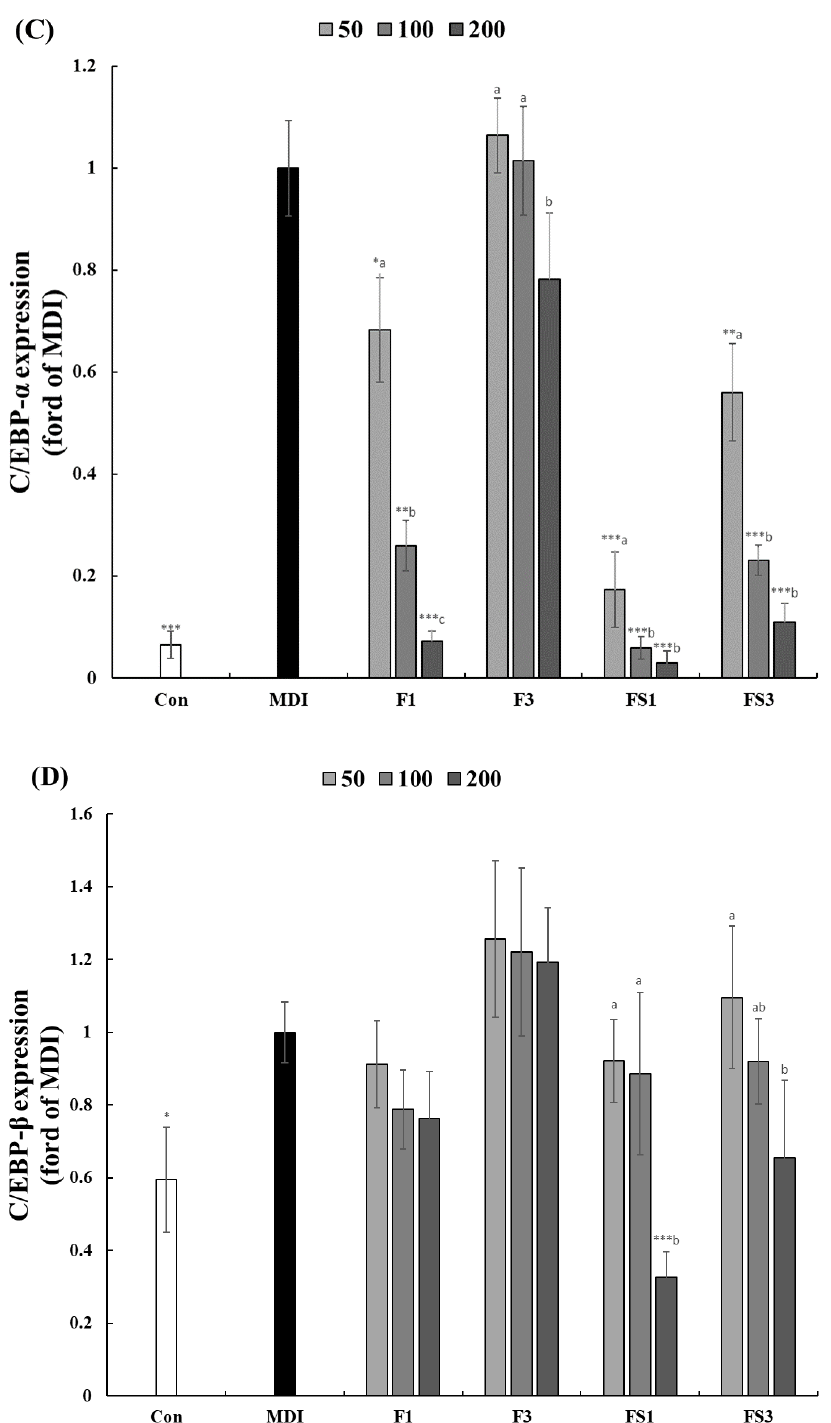
Figure 4. Effects of Cornus officinalis fruit extracts on the expression of proteins linked to adipocyte differentiation in 3T3-L1 cells, as revealed by Western blotting. ( A ) Western blot, ( B ) PPAR- γ , ( C ) C/EBP- α , and ( D ) C/EBP- β . 3T3-L1 preadipocytes were incubated in differentiation medium, with or without CO, from days 0 to 8. Values are means ± SD of triplicate experiments. * p < 0.05; ** p < 0.01; *** p < 0.001. Significant difference by the two-sample Student ’ s t -test between non-treated (MDI) and treated cells. Different small letters on the bars indicate a significant difference ( p < 0.05) among concentrations of the same samples. Samples are listed in Table 1.